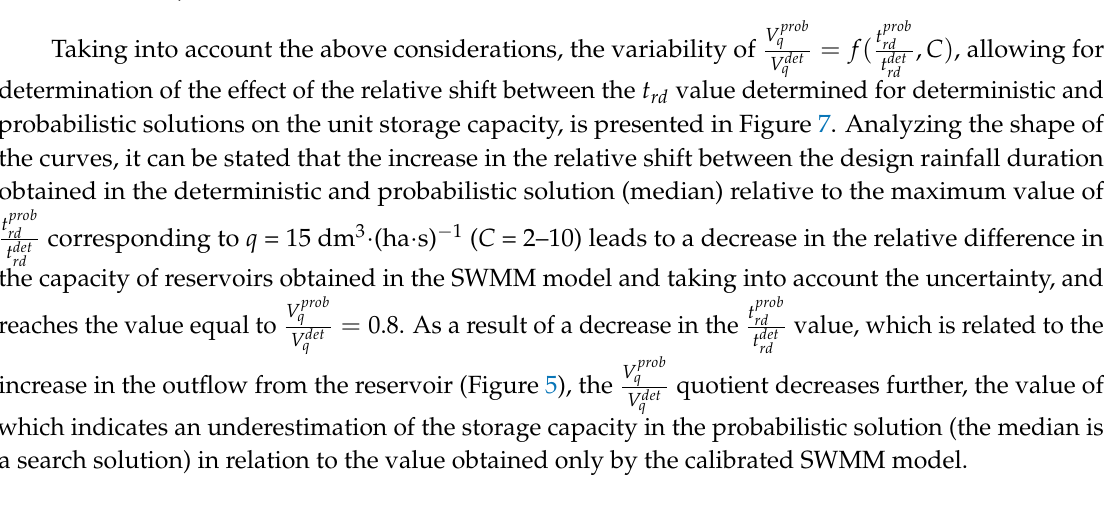
Figure 7. Influence of relative shift between probabilistic and deterministic solution and unit reservoir capacities ( 𝑉 𝑞 ).